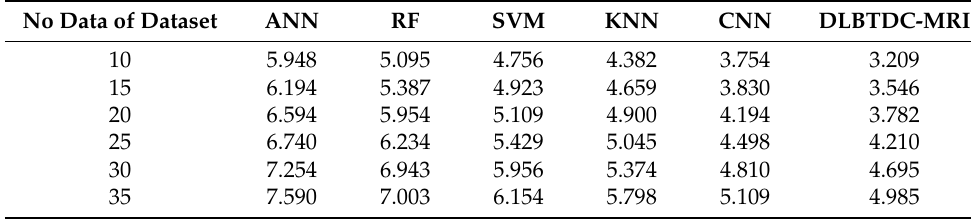
Table 6. Execution time analysis of DLBTDC-MRI method with existing system. No Data of